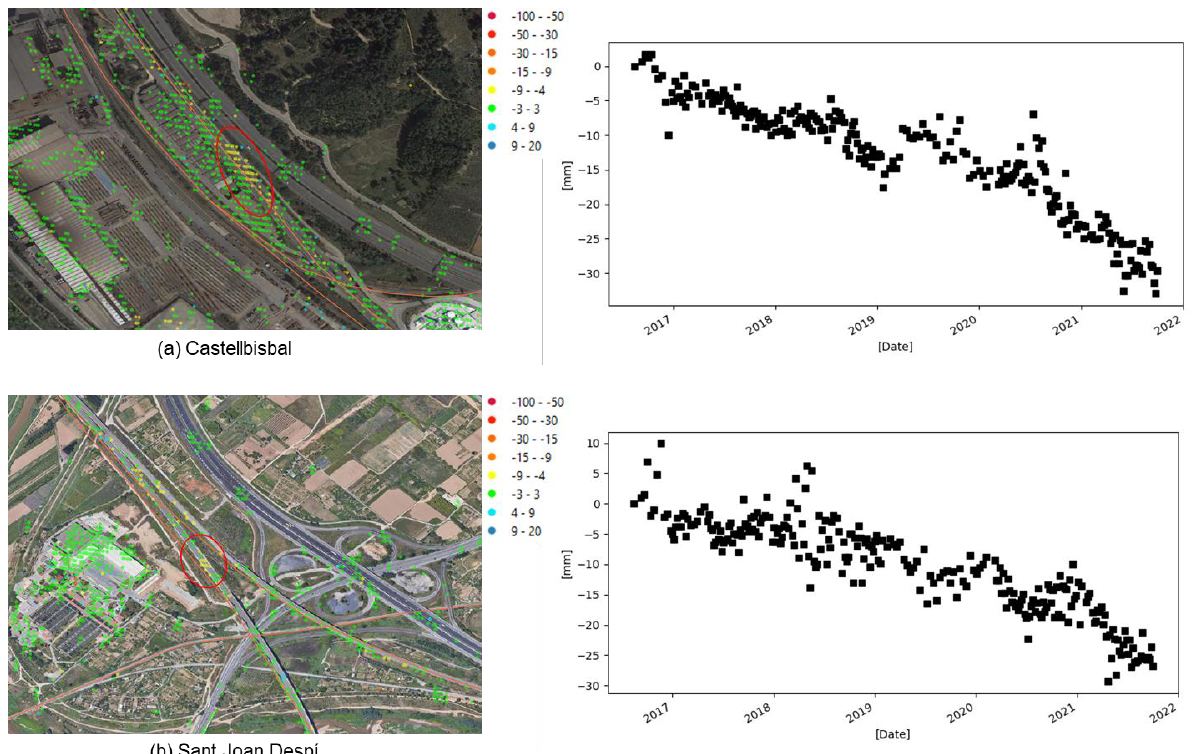
Figure 8. Examples of subsidence areas with time series on the right. (a) subsidence over railway in Castellbisbal (b) subsidence over